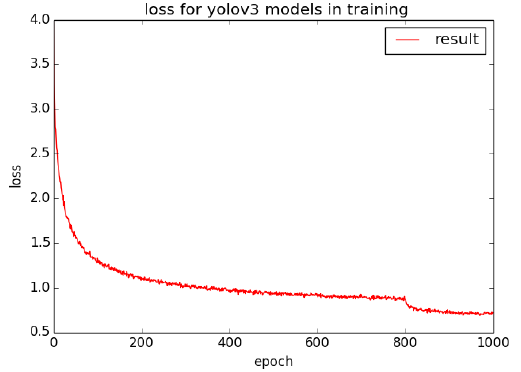
Figure 5. Relationship between iteration number and loss